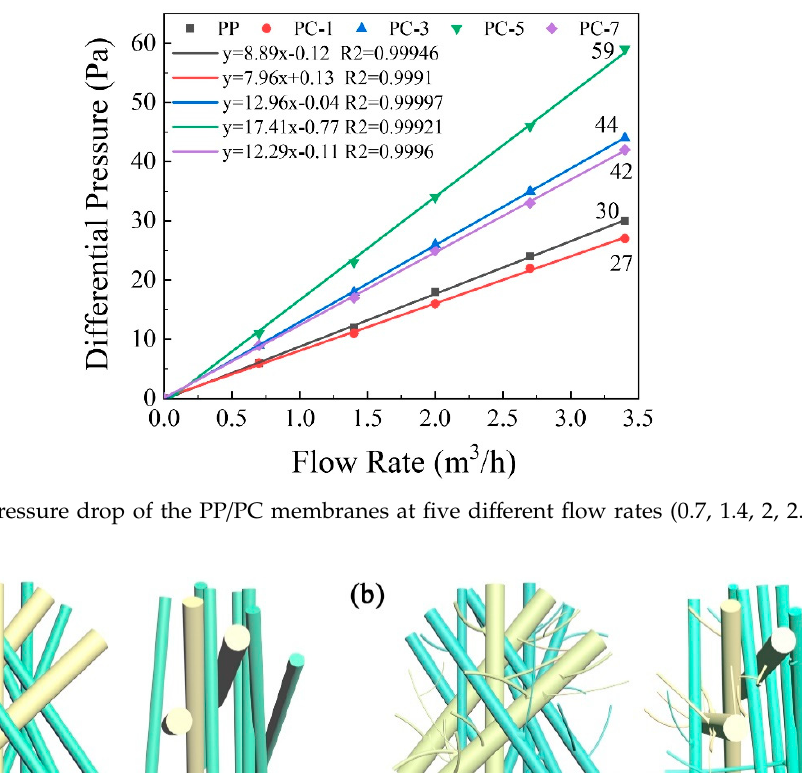
Figure 15. The quality factor of PP meltblown membranes containing different content of PC.